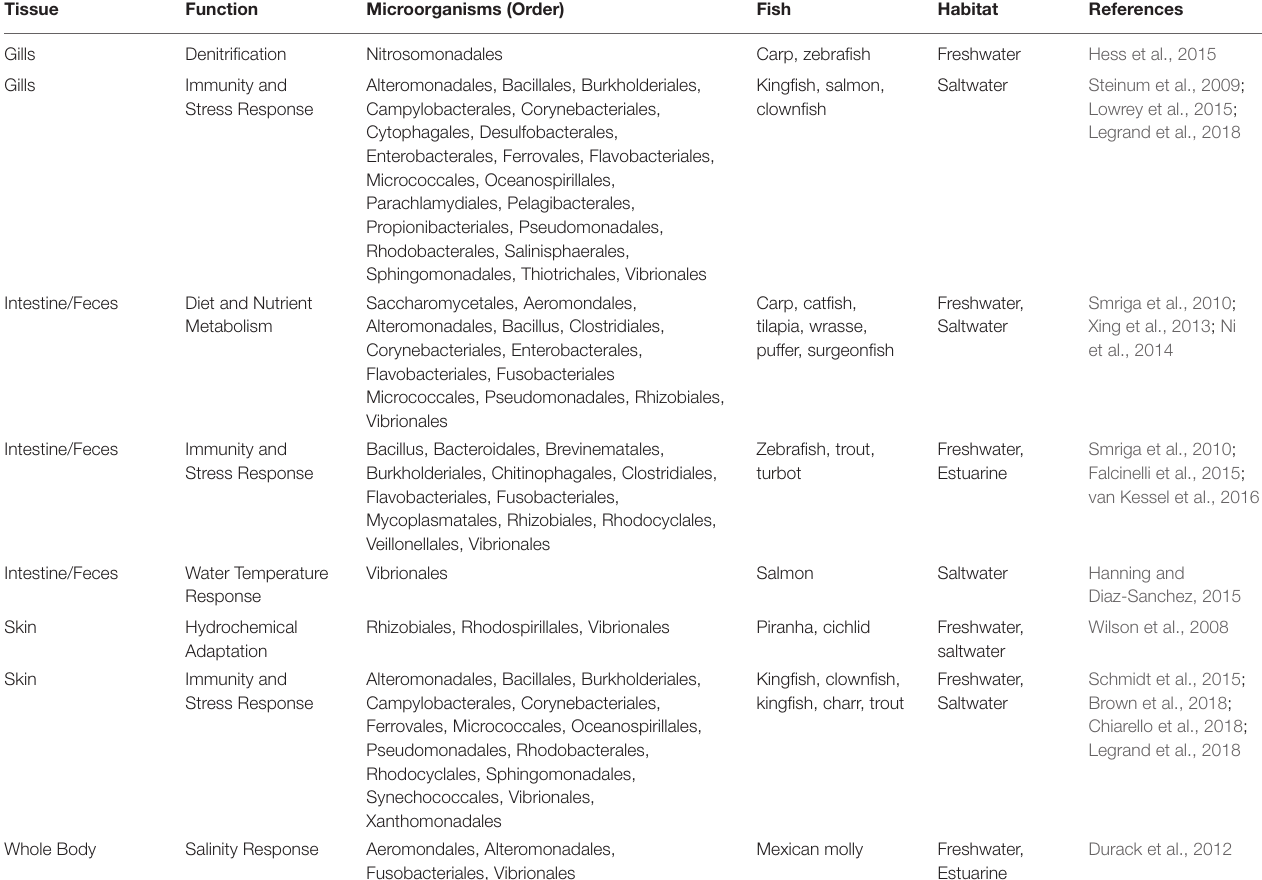
TABLE 1 | The summary of the microbial orders and their organ specific function in different fish